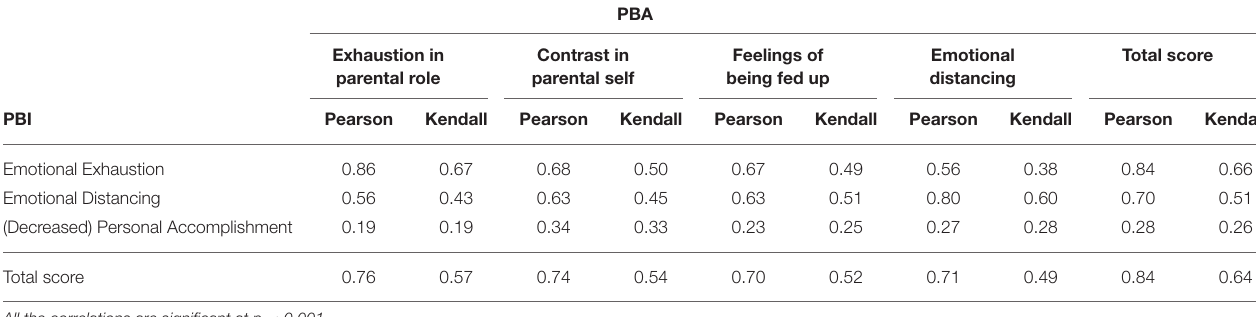
PBA Exhaustion in Contrast in Feelings of Emotional Total score parental role parental self being fed up distancing